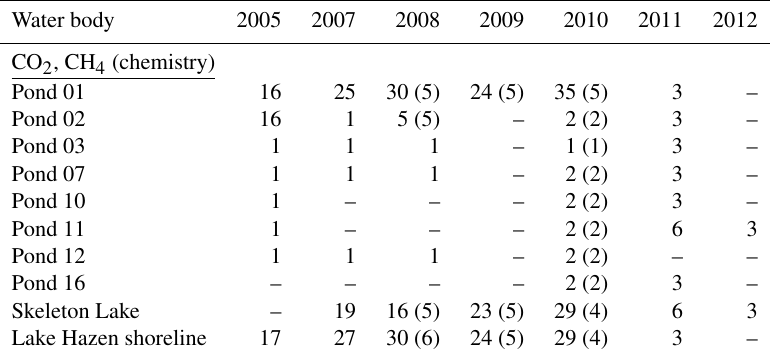
Table 2. Number of samples collected for both dissolved greenhouse gases and general chemical analyses within freshwater systems of the Lake Hazen watershed during the growing seasons (June–August) of 2005 and 2007–2012. All calculated gas fluxes were based on samples collected for concentration